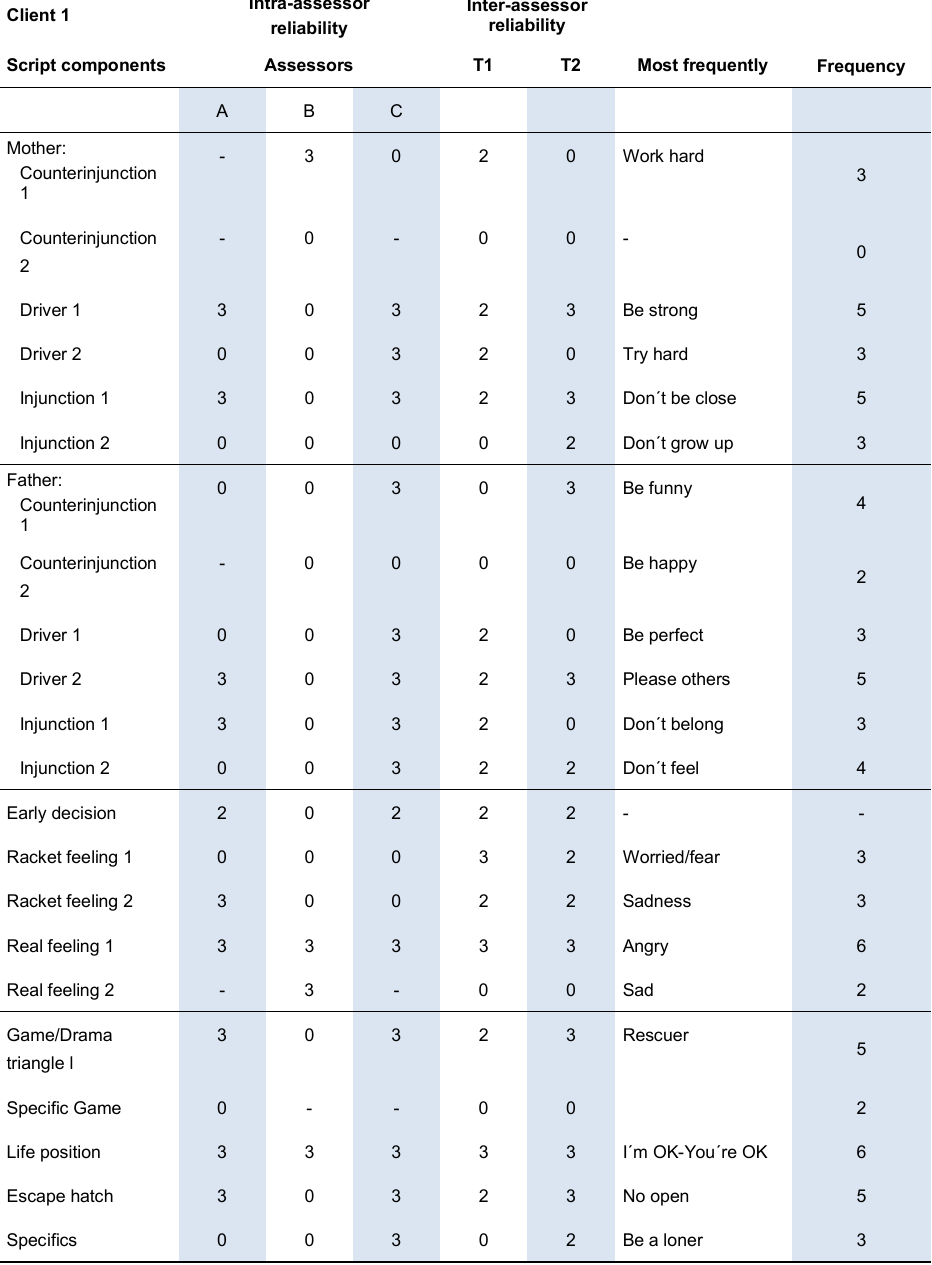
Table 2: Examples of inter- and intra-assessor reliability for Client 1 Client